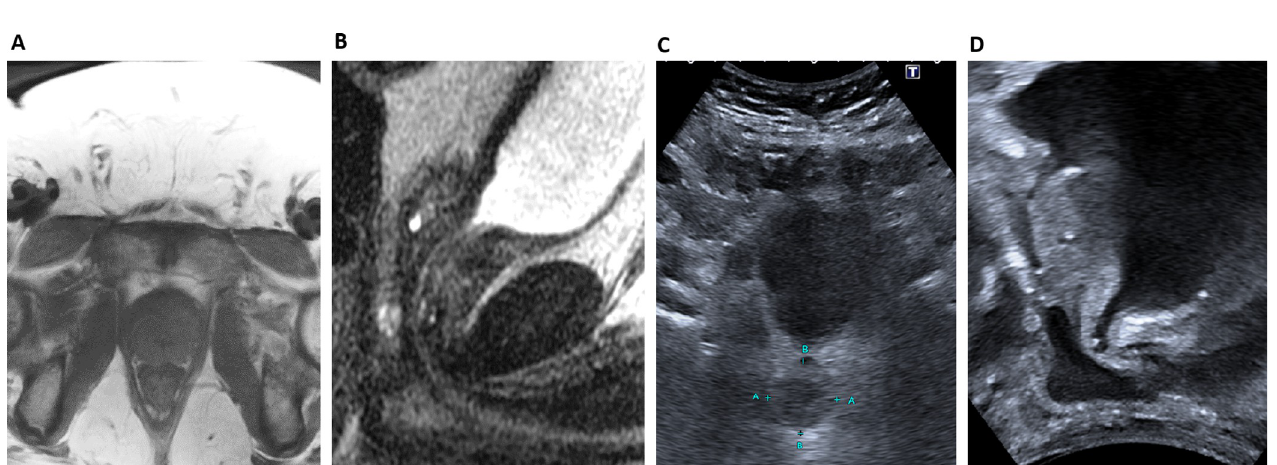
Fig 4. Limited views due to patient body habitus. MRI Axial T1-weighted image (A) shows depth of prostate; corresponding sagittal T2-weighted image of the prostate (B). C: Transabdominal transverse imaging is limited (calipers outline prostate). D: Transperineal sagittal views more clearly demonstrate the prostate.